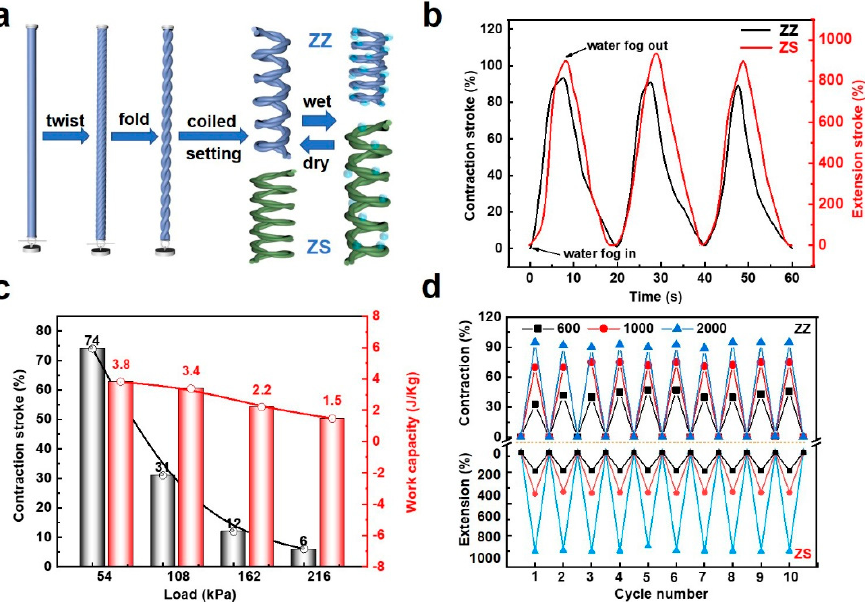
Figure 3. Fabrication and tensile performance of the tensile yarn muscles. ( a ) Illustration of the fabrication process of coiled yarn muscles. ( b ) Tensile stroke as a function of time when alternatively exposed to wet and dry in three cycles. ( c ) Dependence of tensile stroke (black column) on the applied load and the corresponding work capacity (red column). ( d ) Reversible performance over 10 cycles of the tensile yarn muscles with different inserted twists per 25 cm.